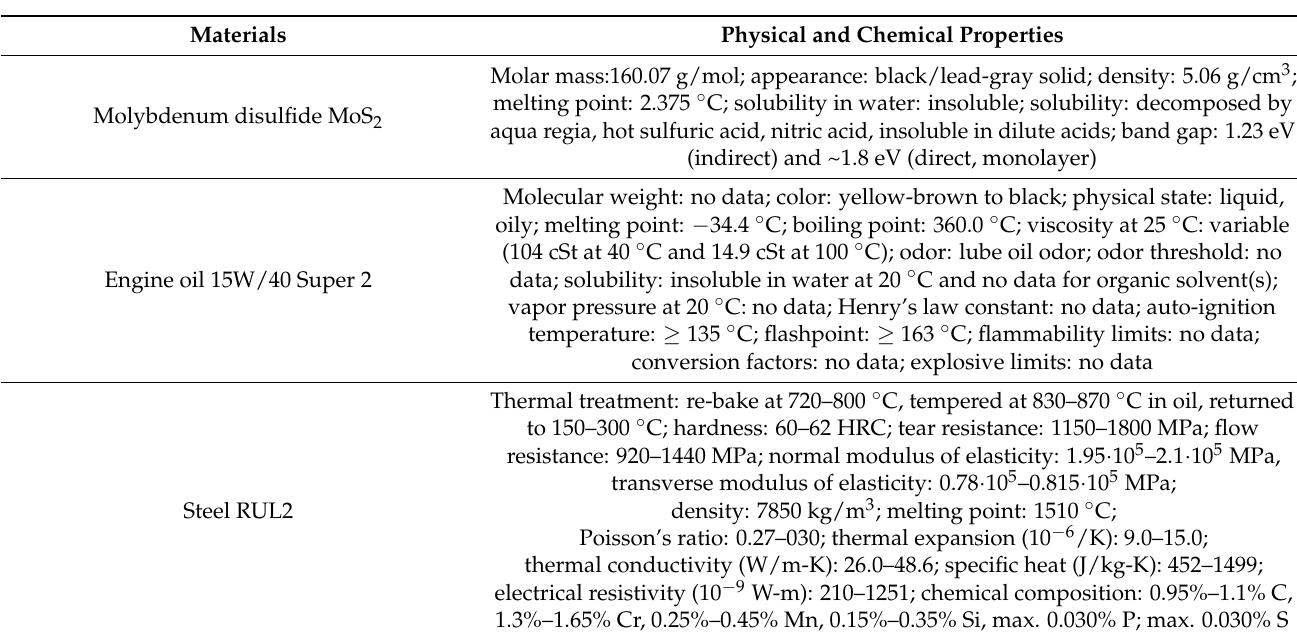
Table 1. Materials used with physical and chemical properties. Materials Physical and Chemical Properties